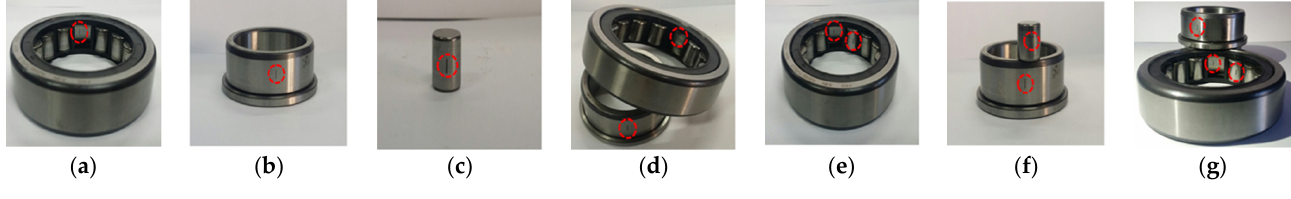
Figure 3. State of the bearing: ( a ) OC, ( b ) IC, ( c ) BC, ( d ) IOC, ( e ) IBC, ( f ) OBC and ( g ) IOBC.